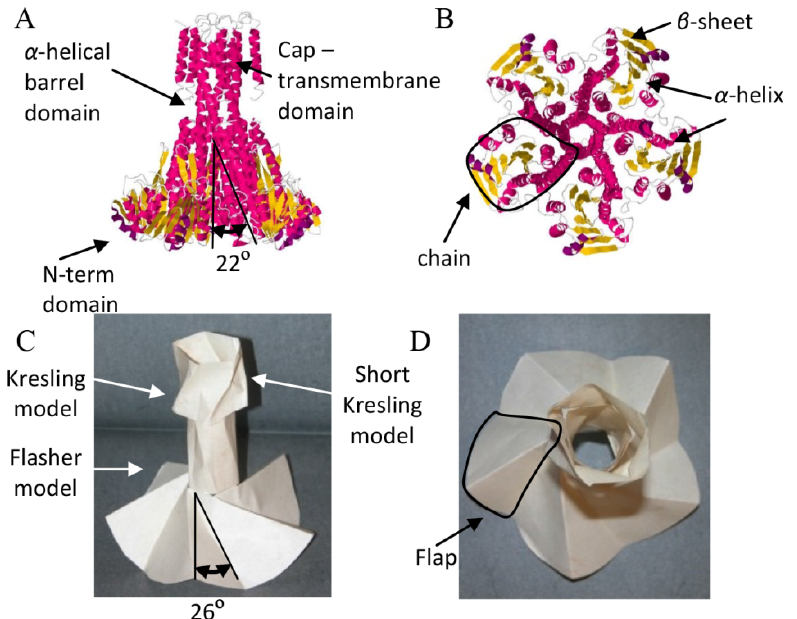
Figure 8. CorA protein structure and analog origami models (reprint from [45] with permission from Elsevier). Protein structure: ( A ) side view of the space-filling model of the CorA protein structure, with cartoon marks for the β -strands (yellow) and α -helices (red) (PDB: 2IUB), and ( B ) top view of the CorA protein structure, with the black line marking one of the chains. Origami model: ( C ) side view of the origami model that is analog to the CorA protein structure, composed from one Flasher model and two Kresling origami models, and ( D ) top view of the analog origami model, with the black line marking one of the flaps.